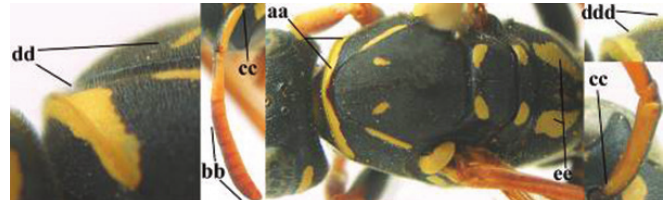
17 Malar space 1.22–1.76 times as long as POL (a); change in sculpture and level between mesepisternum and epicnemium abrupt (b; = epicnemial ridge distinct); yellow lateral stripes of pronotum usually absent (c); tegula in most specimens with large dark medial spot, reaching outer margin (d);